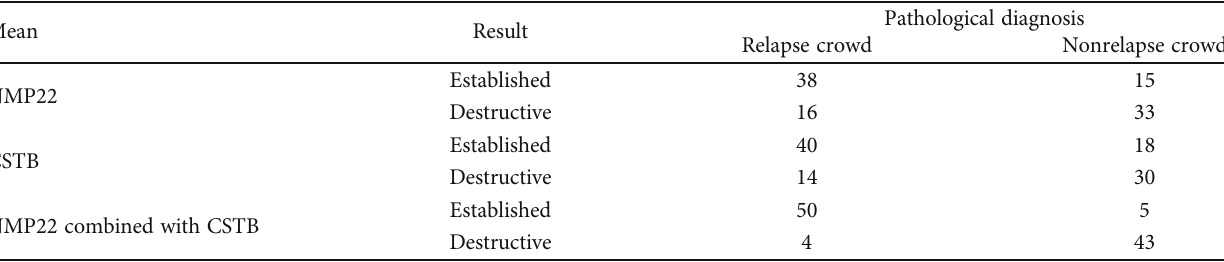
Table 4: Testing results of each mean in each crowd (example, n ).